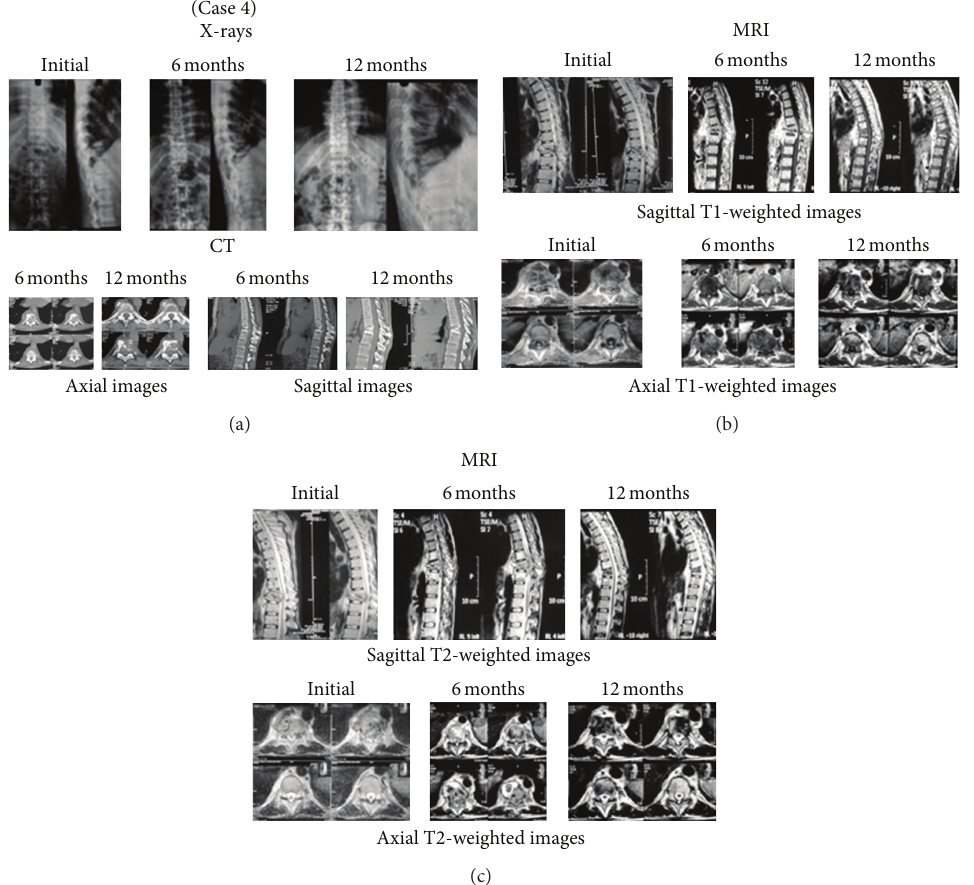
Figure 3: Tubercular spondylitisthoracic (D9-D10) with neurologic deficit. VATS along with minithoracotomy and placement of bone graft wasdone.Conversiontominithoracotomywasdonebecauseofdensepleuraladhesionsanddifficultyinmakingportalswasalsoencountered.